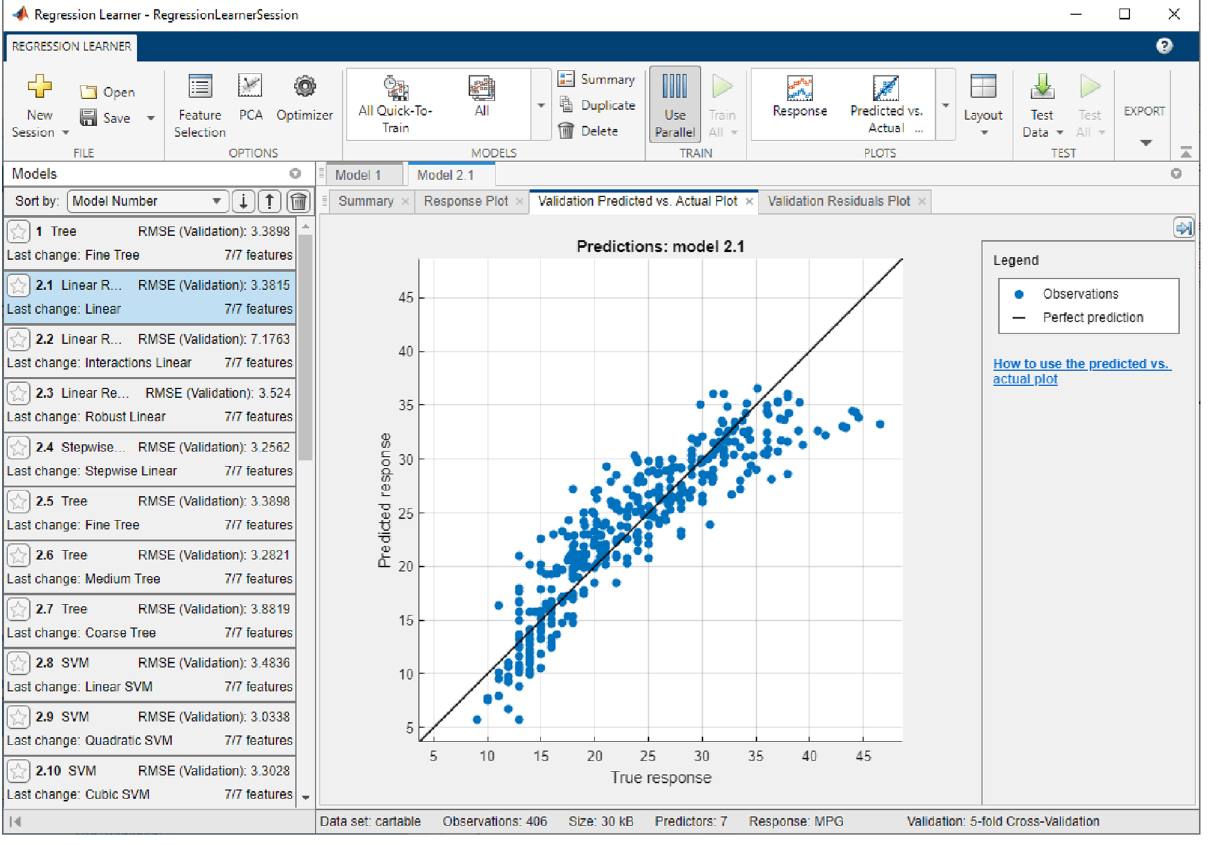
Figure 7. Training results for the selected minimal test error model and correlation graph estimations in the Matlab Regression Learner App